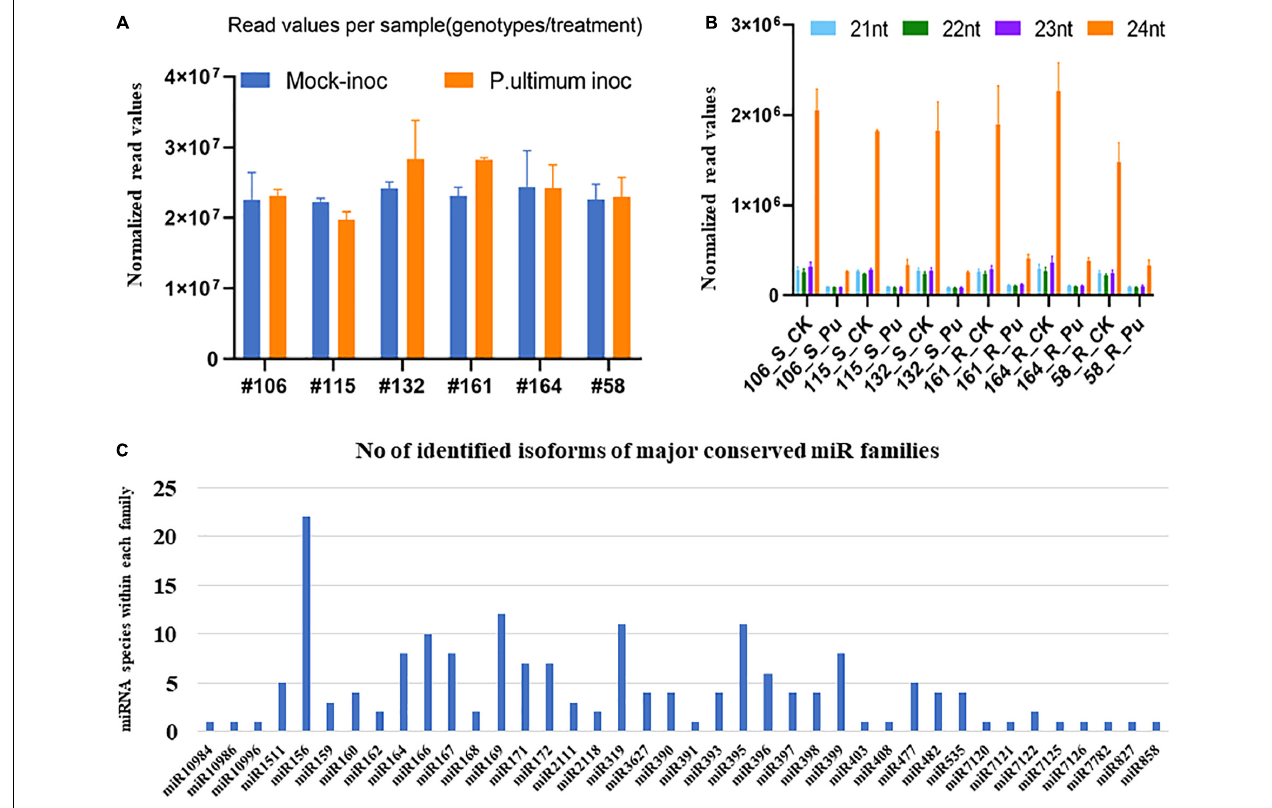
FIGURE 2 | Overall statistics of identified miRNAs in apple roots. (A) The average numbers of sequence reads from three replicates for each sample (genotype/treatment). (B) Size distribution of small RNAs based on number of unique sequence reads. (C) Size of family of major miRNA in apple roots.